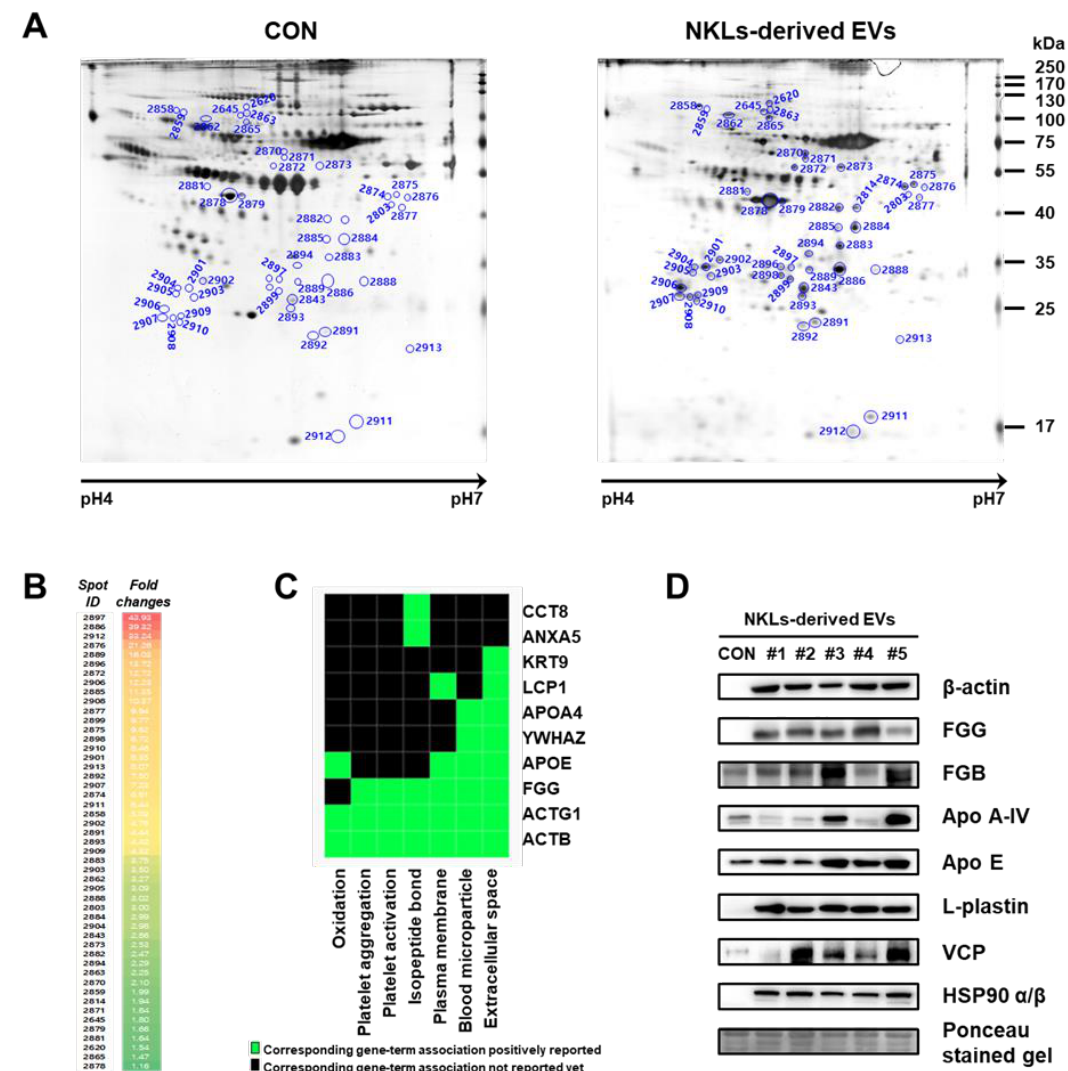
Figure 5. Proteome analysis of NKL-derived EVs. ( A ) Representative silver-stained two-dimensional electrophoresis (2-DE) gel images of control EVs (CON) and NKL-derived EVs ( B ) Spots with increased intensity and their fold changes in NKL-derived EVs compared to CON. A high-resolution image along with 2-DE gel images is presented in Figure S1. ( C ) Gene-Term 2D Heat map view using DAVID Bioinformatics resources. ( D ) The expression of increased proteins was confirmed by immunoblot analysis. 2-DE experiments were performed in triplicate per individual.